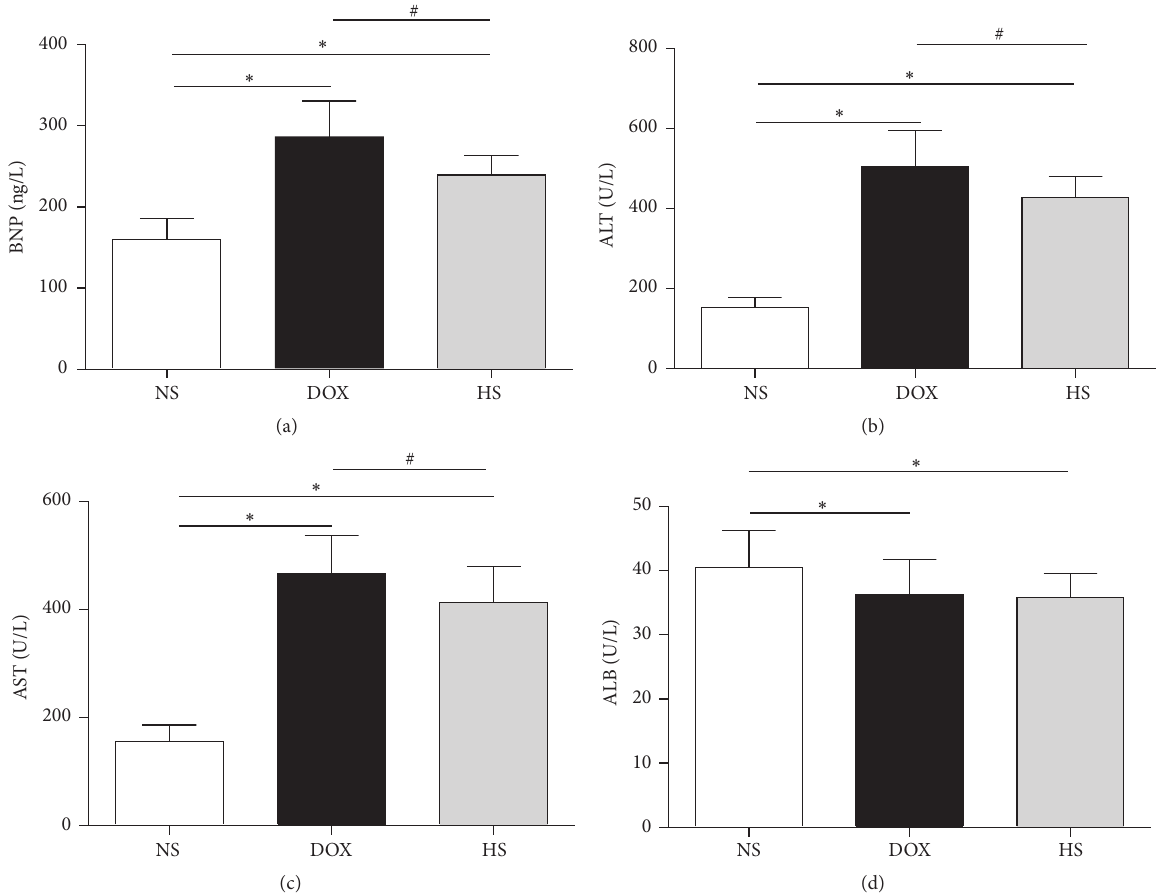
Figure 2: Effect of hydrogen-rich saline on serum parameters. Serum BNP (a), ALT (b), AST (c), and ALB (d) levels in three groups were detected. Data are shown as mean ± SD. ∗ 𝑃 < 0.05 versus NS group; # 𝑃 < 0.05 versus DOX group.